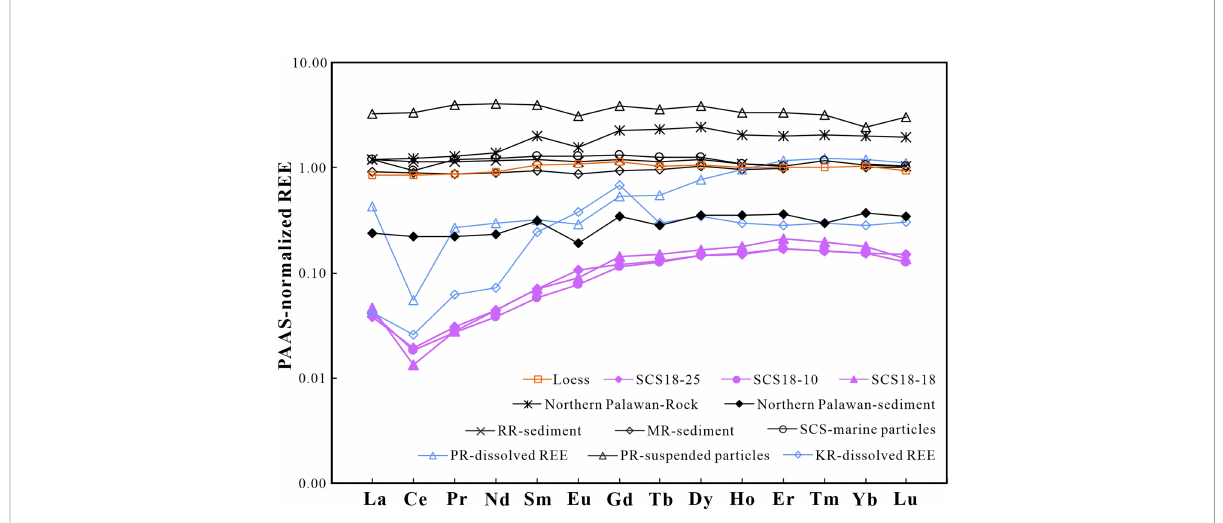
FIGURE 5 PAAS-normalized REE patterns of surface water in the SCS (× 10 6 ), Pearl River (PR) water (× 1; NA: 22.53° N, 113.49° E) and PR suspended particles (× 10 − 3 ; L7: 22.06° N, 113.50° E) (Ma et al., 2019), Kaoping River (KP) water (× 10 2 ; KP3) (Chung et al., 2009), Red River sediment (RR, × 10 − 3 ; 20: 20.26° N, 106.52° E) (Bayon et al., 2015), loess (× 10 − 3; Ding et al., 2001), northern Palawan rock (× 10 − 3) and sediment (× 10 − 3) (Padrones et al., 2017), Mekong River sediment (MR, × 10 − 3 ; 12: 10.96° N, 105.06° E) (Bayon et al., 2015), and northern SCS sinking particles (× 10 − 3 ; SCS-NW-1: 17.43° N, 110.67° E) (Liu et al.,